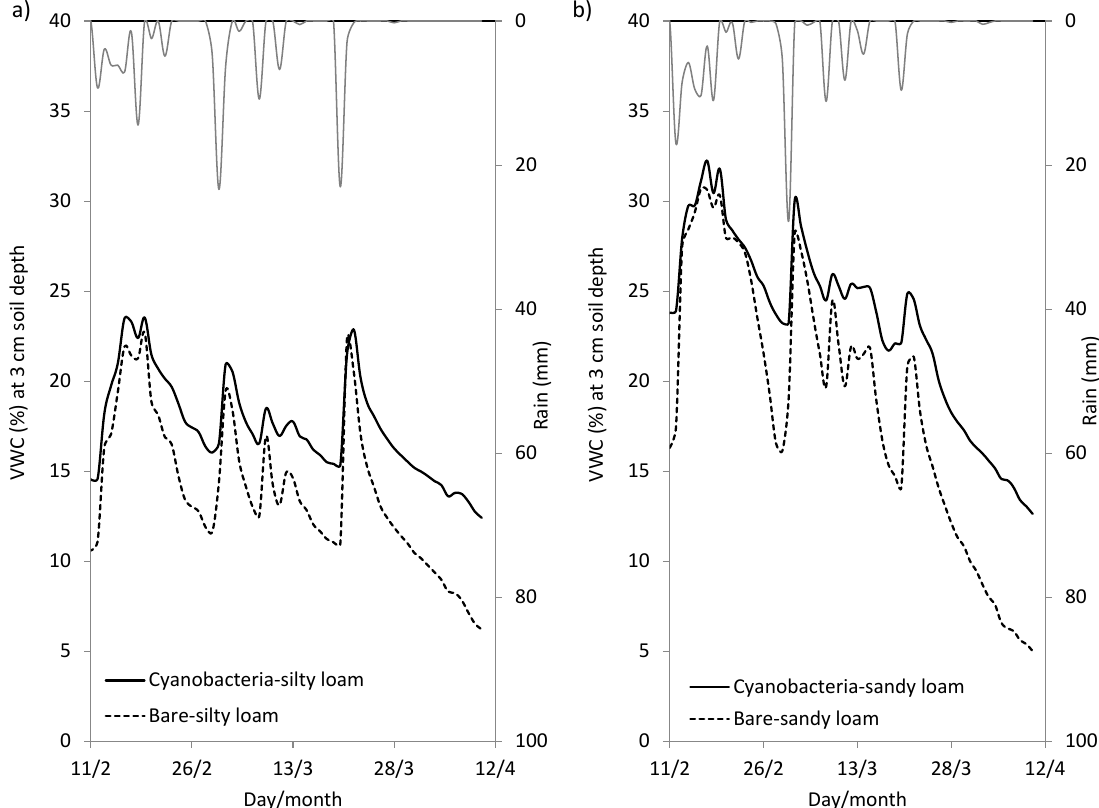
Figure 3. Volumetric water content (VWC, %) during a wet soil period in cyanobacteria-covered and bare soils at both study sites, ( a ) El Cautivo (silty loam soils) and ( b ) Las Amoladeras (sandy loam soils).